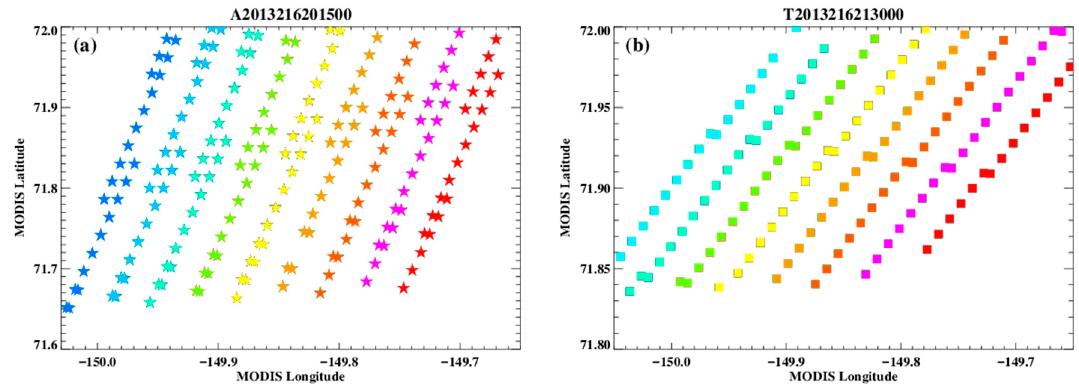
Figure 6. MODIS along-track scan spots for the Aqua ( a ) and Terra ( b ) granules that were used to compute the satellite horizontal wavenumber spectra.